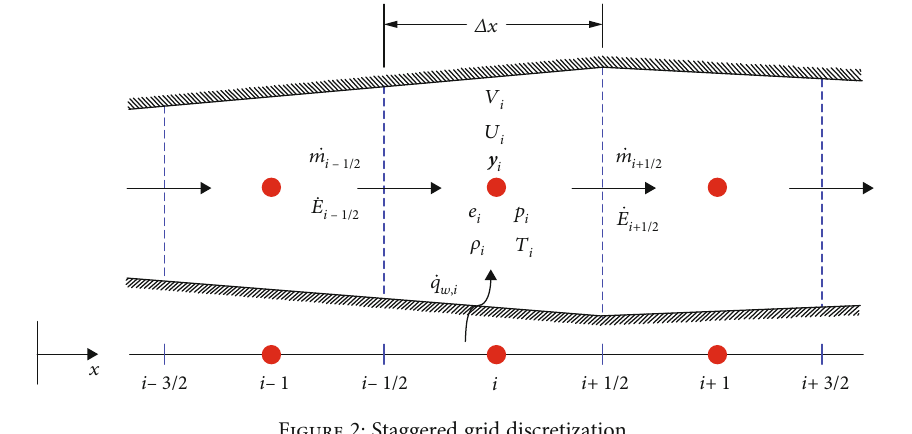
Figure 2: Staggered grid